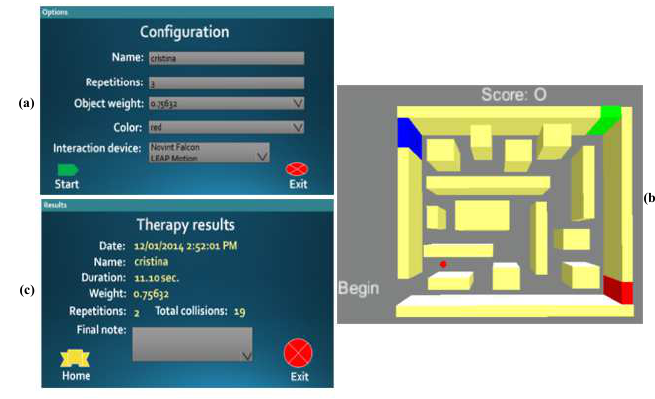
Fig. 1. Haptic–enhanced virtual environment: (a) therapy configuration; (b) exercise in the virtual maze for wrist therapy; (c) therapy